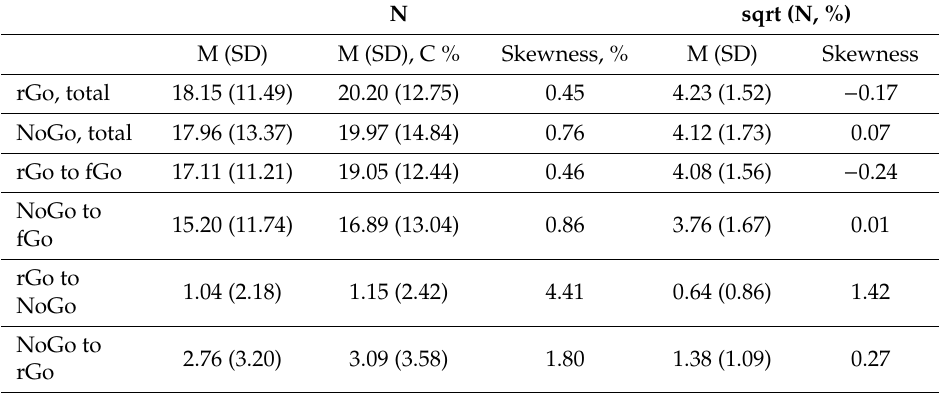
Figure 2. The error rates for total number and subcategories of errors for rare Go and NoGo stimuli. Table 2. The error rates for rare Go and NoGo